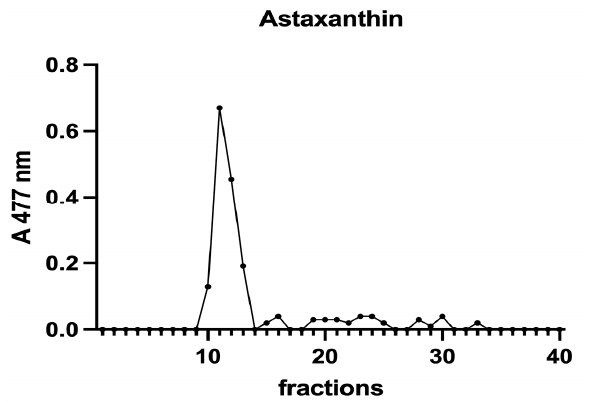
Figure 6. Chromatographic profiles of chlorophyll a after SEC of extracts from algal biomass. Chlo- rophyll a was detected at 430 nm. Each chromatographic profile is the mean of two chroma- tographies.